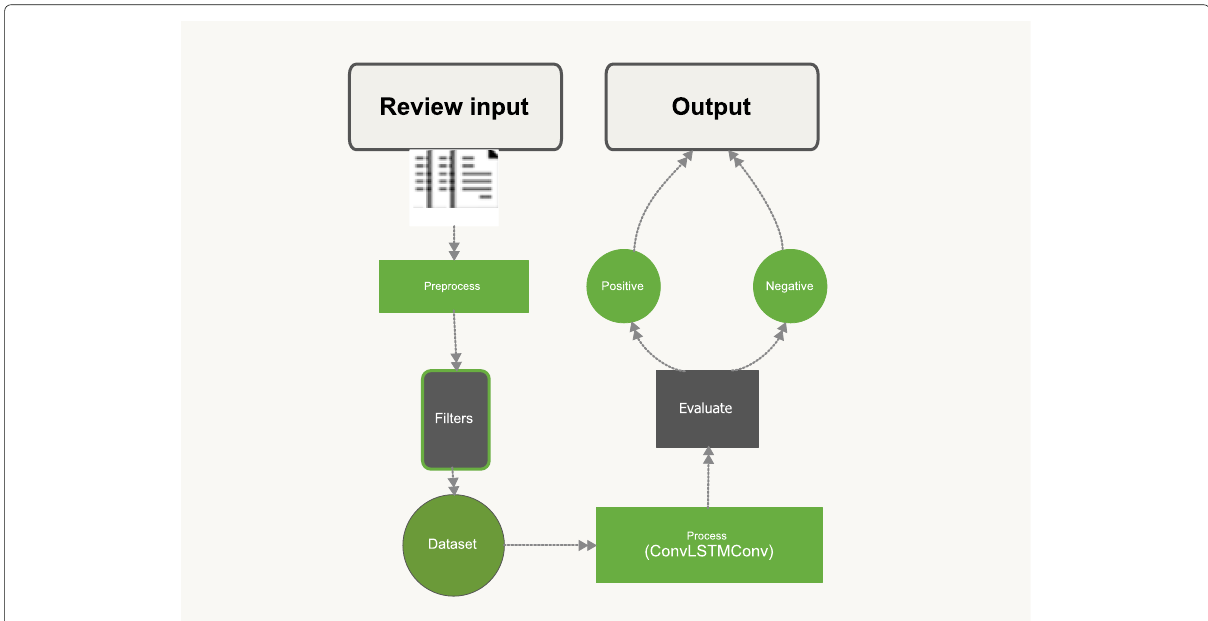
Fig. 1 General block diagram for our ConvLSTMConv proposed